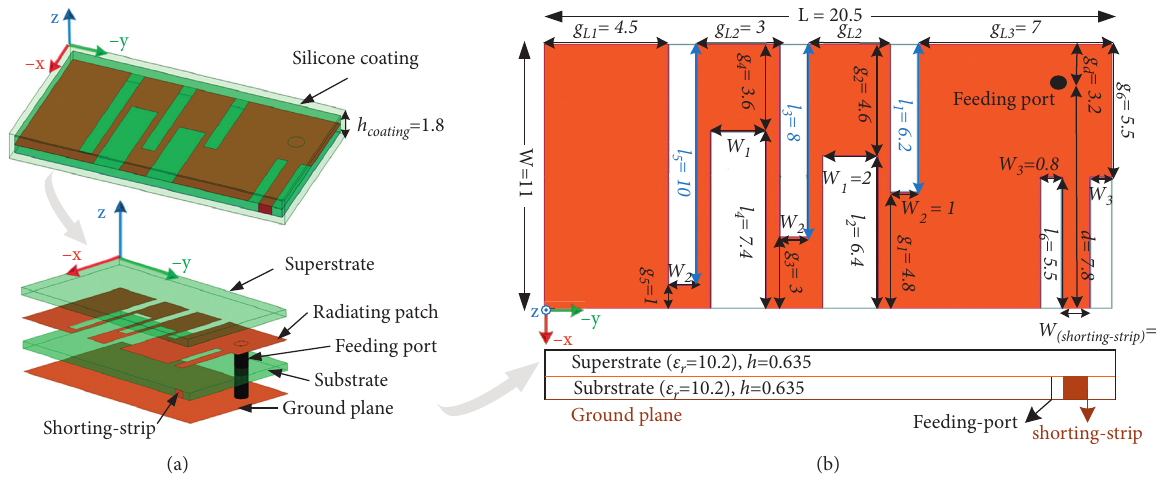
Figure 2: The proposed meandered triple-band implantable PIFA configuration. (a) The structure of the proposed PIFA and (b) its geometrical parameters (all dimensional parameters are given in the units of